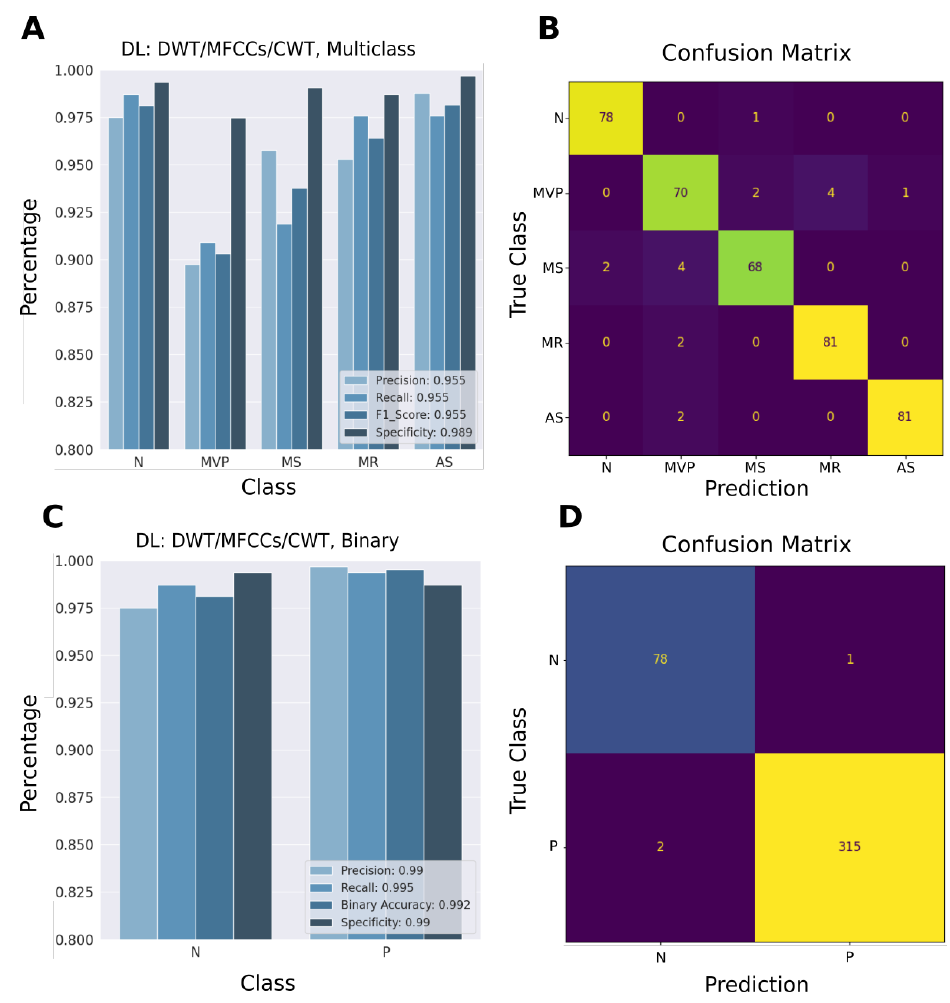
Figure 9. DL performance results (20% of dataset as test set): ( A , C ) Precision, recall, F1 score and specificity of the complete model for the testing set in a multiclass and binary classification, respectively. The vertical axis shows only the percentage from 0.8 to 1.0 to facilitate the visualization of the results. ( B , D ) Confusion matrices for multiclass and binary classification, respectively.